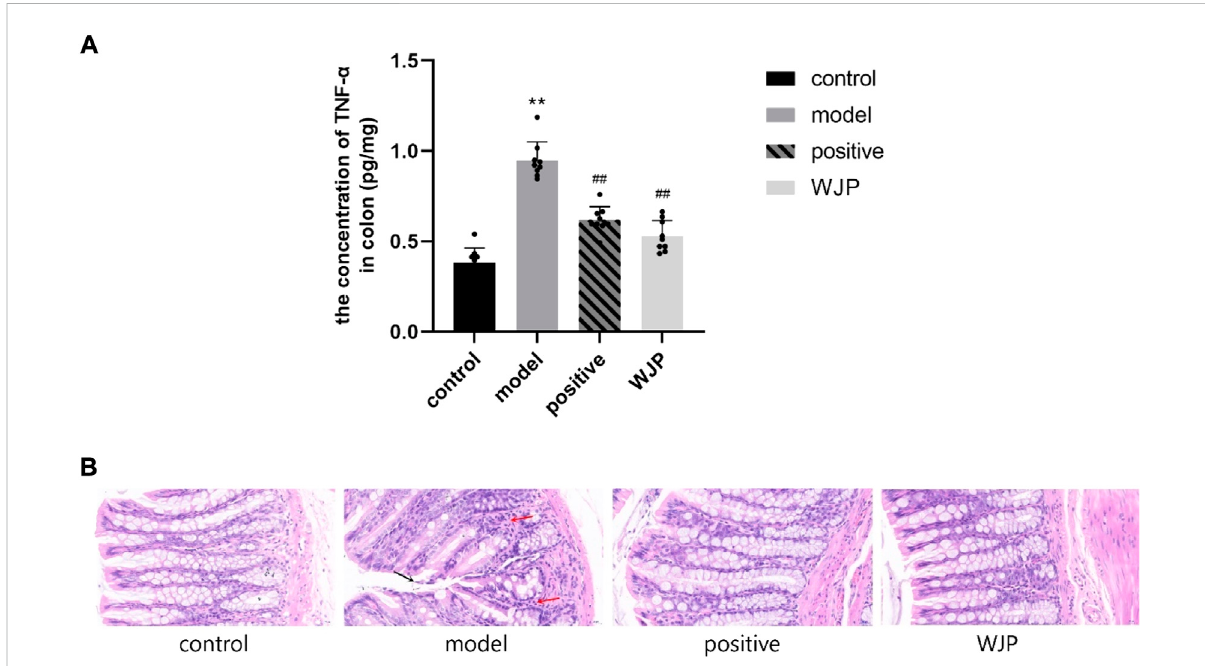
FIGURE 6 Comparison oftheconcentrationofTNF- α inthecolonandthehistopathological observation ofcolontissue. (A) Concentration ofTNF- α .* p < 0.05; ** p < 0.01, versus the control group. # p < 0.05; ## p < 0.01, versus the model group. (B) Histological changes in each group observed after HE staining. Magni fi cation ×400. A small amount of epithelial cell shedding can be seen in local mucosa (black arrow). More lymphocyte in fi ltration can be seen in local lamina propria (red